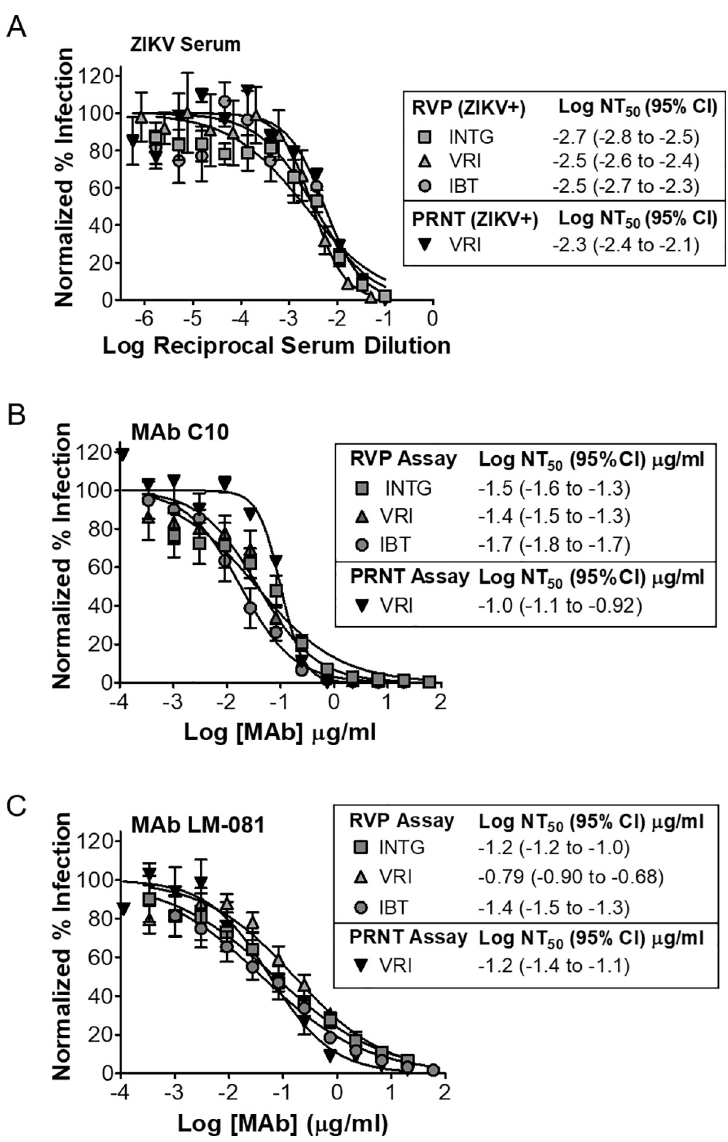
Fig 5. ZIKV RVPs are reproducibly neutralized in different laboratories by human serum from a ZIKV positive patient and by MAbs. (A) ZIKV RVP neutralization experiments using serum from a ZIKV infected individual (closed symbols) were conducted in three different laboratories: Integral Molecular (INTG), Vitalant Research Institute (VRI) and Integrated Biotherapeutics (IBT). Serum from an uninfected individual was used as a negative control (open symbols). Neutralization experiments were performed in different laboratories using MAbs (B) C10 and (C) LM-081. Data points for RVP neutralization assays represent the mean and standard deviation for 5–8 replicate data points. For PRNT assays, data points represent the mean and range of 2